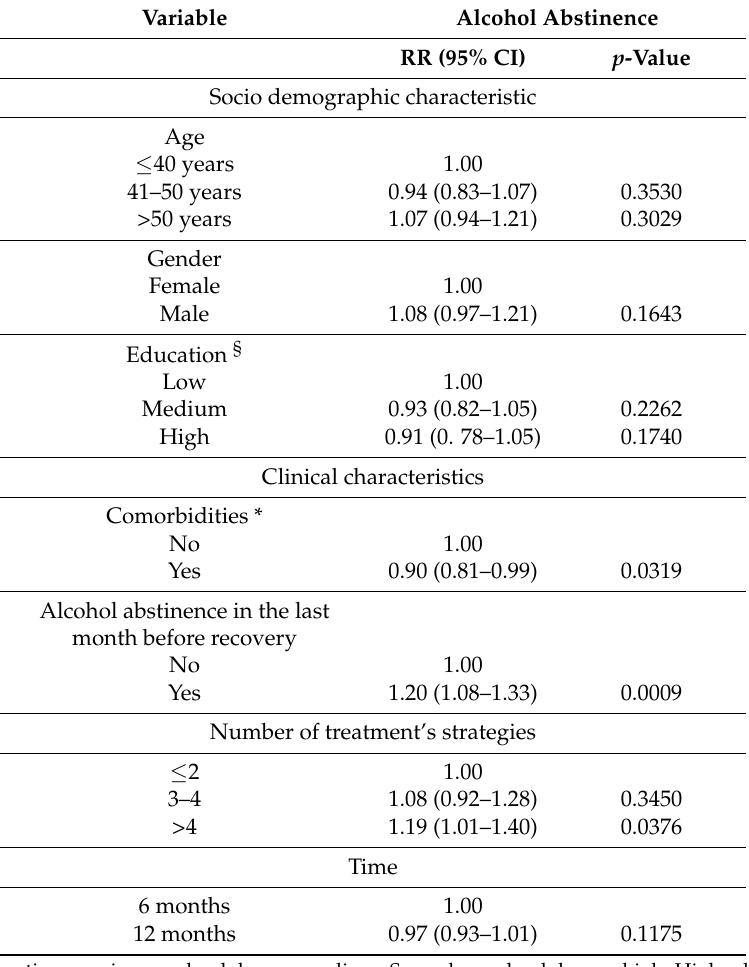
Table 3. Association between sociodemographic and clinical characteristics, and the number of treatment strategies and alcohol abstinence at six and 12 months, using multivariate